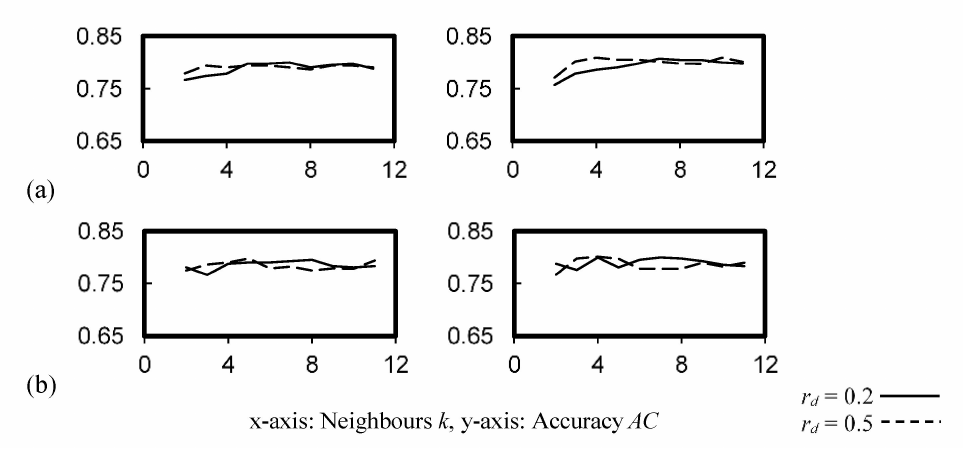
Figure 4. Cross-validation accuracy of the k NN classifier. ( a ) W = 1/ d k , ( b ) W = 1.